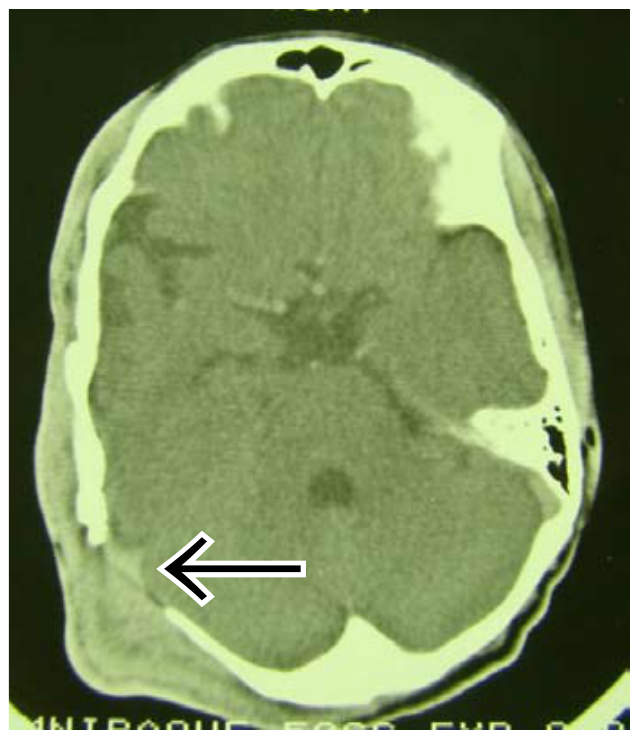
Fig. 2b. Contrast-enhanced axial brain CT with right lambdoid suture defect with an overlying plexiform neurofibroma.